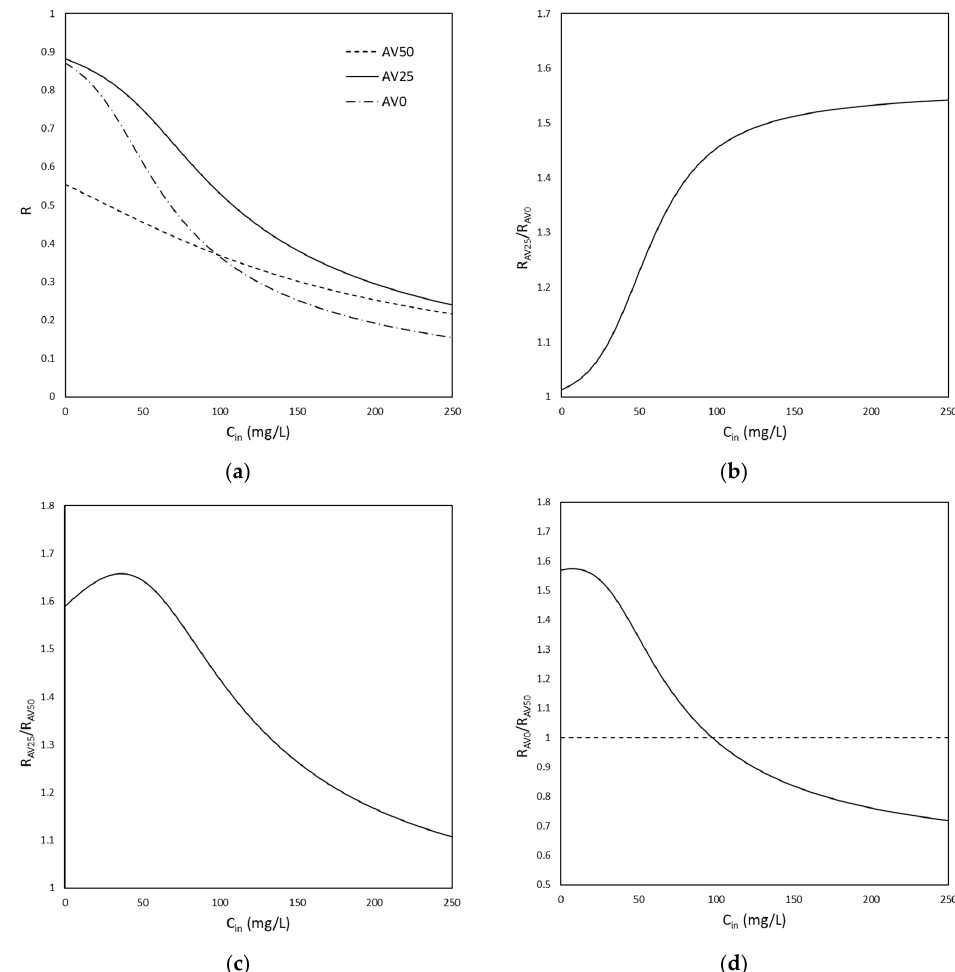
Figure 6. ( a ) Plot of the removal percentage at equilibrium of MB ( R ) vs. the initial concentration for AV0, AV25, and AV50; ( b ) plot of the ratio R AV 25 / R AV 0 versus the initial concentration; ( c ) plot of the ratio R AV 25 / R AV 50 versus the initial concentration; ( d ) plot of the ratio R AV 0 / R AV 50 versus the initial concentration.